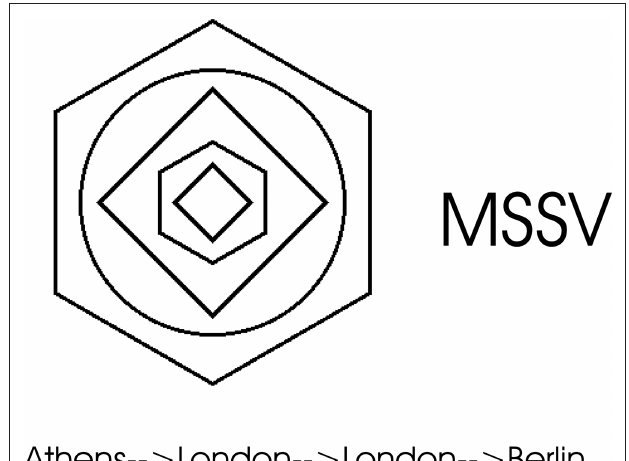
Figure 2 | examples of the types of stimuli used in Pothos et al. ( 2006)